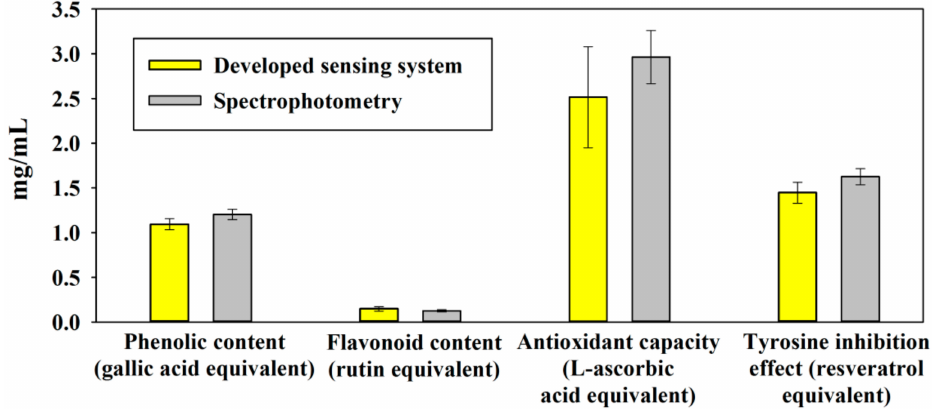
Figure 12. Multi-assay of Rosa roxburghii juice using the developed system and spectrophotometric